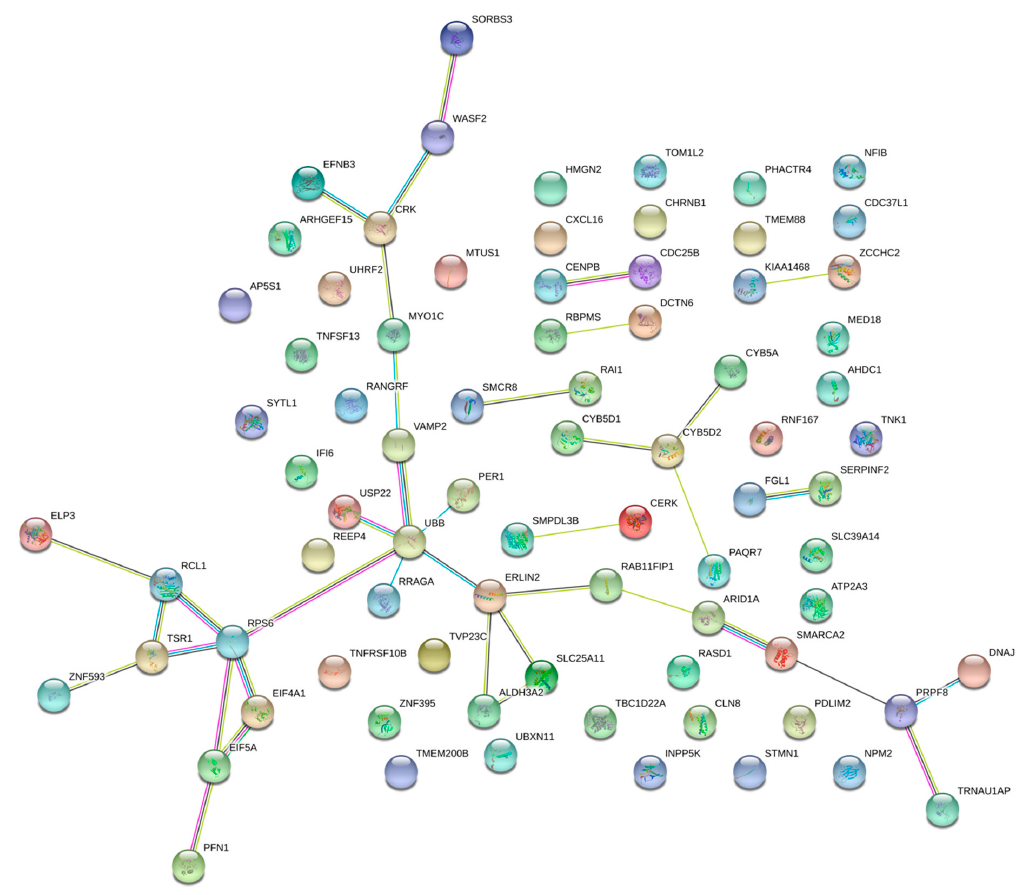
Figure 2. Gene interaction network of genes downregulated due to copy number loss in their regulatory enhancer region. Nodes represent proteins and edges represent protein–protein associations.